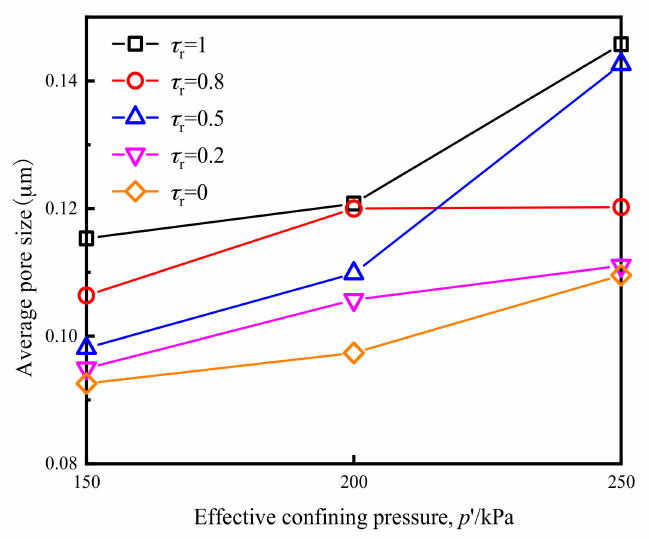
Figure 17. Average pore diameter of soft clay under the influence of p (cid:48) .